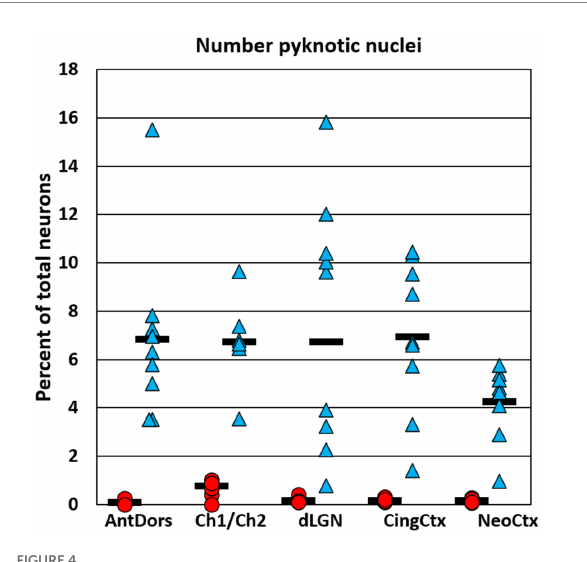
FIGURE 3 Bar graphs show the ethanol-induced neuron loss at P70 from different brain regions in the present study (“Nissl neurons,” at left). For comparison, at right are stereological estimates of immunolabeled neuron populations from previous studies using the same treatment paradigm. * Results are from Smiley et al. (2021). ** Results are from Smiley et al. (2019). Abbreviations: 5HT DR, serotonin neurons of dorsal raphe; AntDors, anterior dorsal thalamic nucleus; AntMed, anterior medial thalamic nucleus; AntVent, anterior ventral thalamic nucleus; ChAT, choline acetyl transferase immunolabeled cells; Ch1/Ch2, medial septum and vertical diagonal band region; Ch3/Ch4, horizontal diagonal band and nucleus basalis region; Ch5/Ch6, pedunculopontine and lateral dorsal tegmental nuclei; CingCtx, cingulate cortex; CR, calretinin immunolabeled cells; DA SN/VTA, dopamine cells of substantia nigra and ventral tegmental area; dLGN, dorsal lateral geniculate nucleus; dSubic, dorsal subiculum; Mamm, mamillary bodies; NeoCtx, neocortex; NeuN, neuronal nuclear antibody immunolabeled cells; Orexin, orexin cells of the hypothalamus; PV, parvalbumin immunolabeled cells; SST, somatostatin immunolabeled cells.